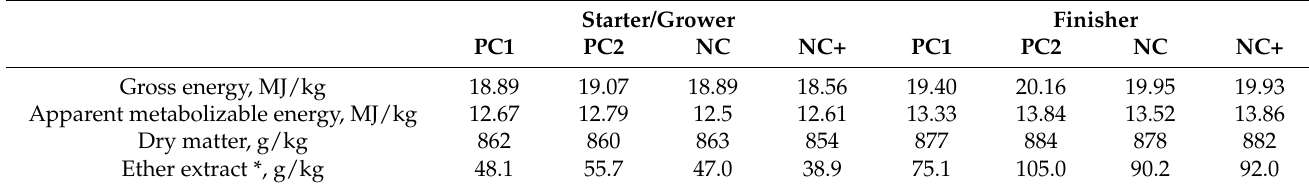
Table 2. Analysed nutrient composition of experimental starter/grower and finisher diets.